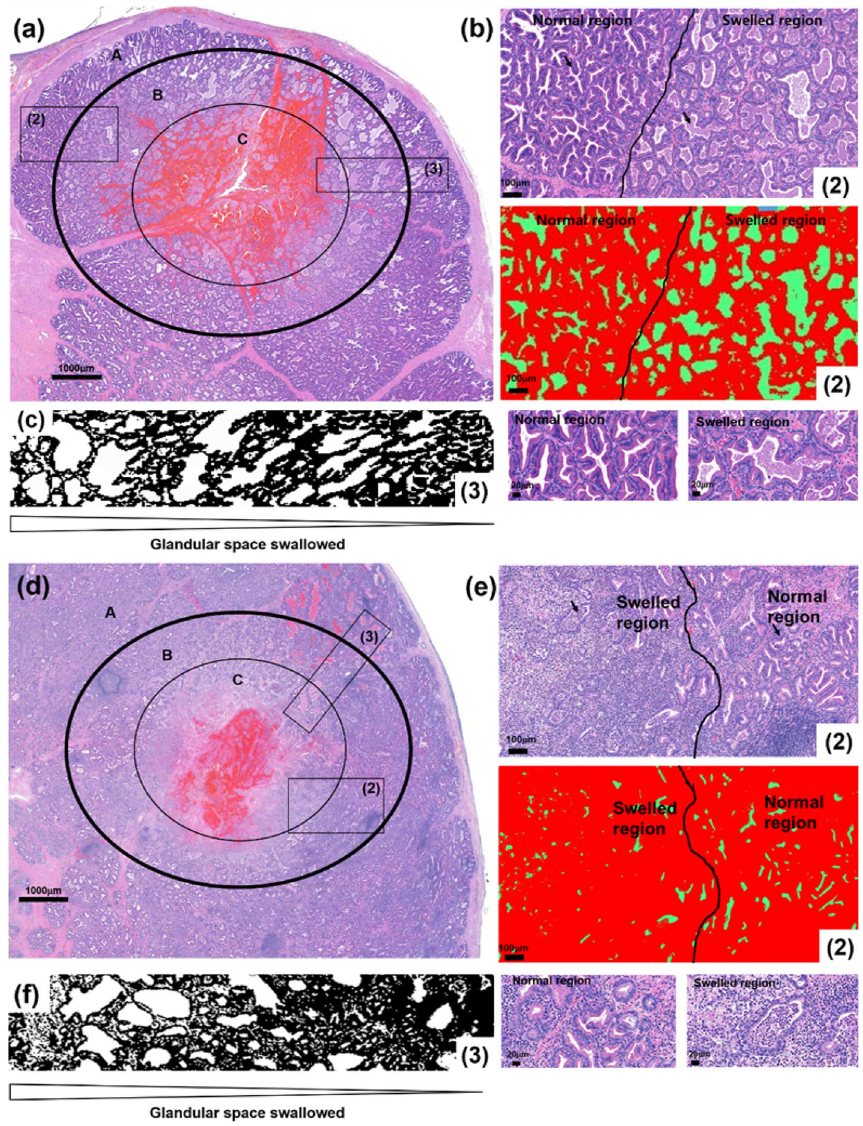
Figure 4. Effects of IRE on the shapes of prostate tissue. ( a , b ) Histologic examination, showing that normal ( A ), swollen ( B ), and completely ablated ( C ) areas of prostate tissue were not affected by ( a ) 500 and ( d ) 700 V. Demarcations between intact (1) and swollen (2) tissue are observed in ( a ) and ( e ). The acinar cells around the swollen glandular tissues were almost completely intact. The tendency to swell was dependent on the distance from the electrode (3) in ( a ) and ( d